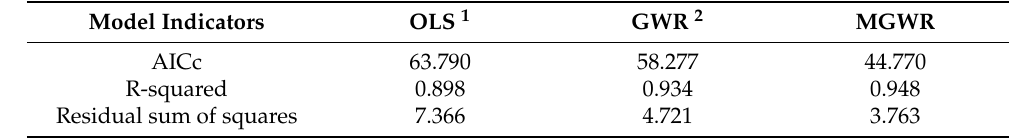
Table 7. Comparison of fitting results for OLS, GWR and MGWR models.